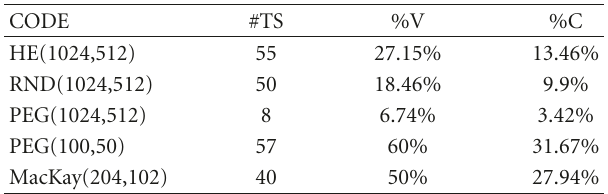
Table 4: Identified trapping sets and configuration percentages for di ff erent LDPC codes.